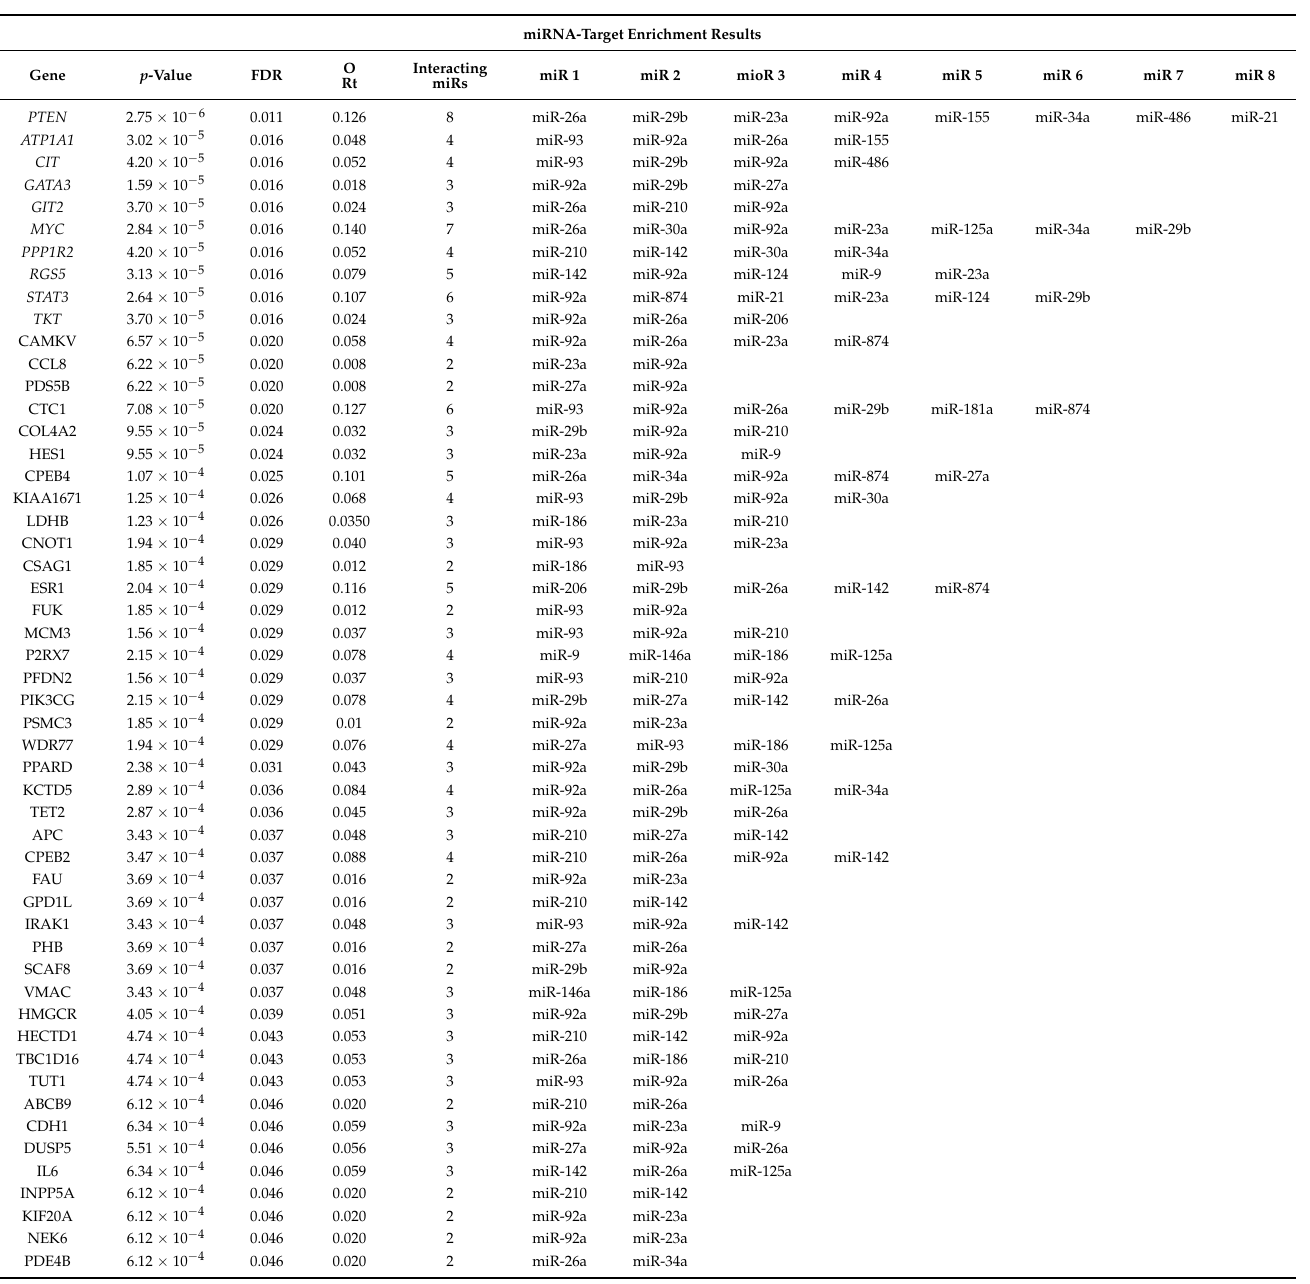
Table 1. Gene targets significantly associated with the 21 miRNA markers candidates for the in silico